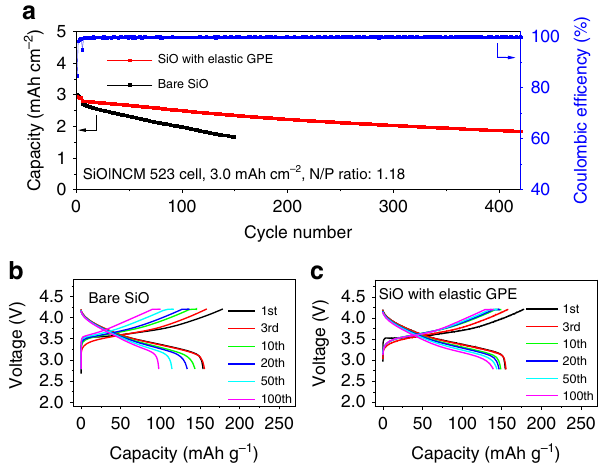
Fig. 5 Cycling stability of SiO|NCM cells. a Discharge capacities of SiO| NCM 523 cells at a current density of 1.0 mA cm − 2 and the Coulombic ef fi ciency of the cell incorporating the elastic GPE. b , c Voltage pro fi les of the SiO|NCM 523 cells with ( b ) and without ( c ) the elastic GPE. Pre-cycled SiO electrodes were used for full-cell assembling. The mass loading of SiO anodes is 4.7 mg cm − 2 , and the copolymer amount is 0.4 mg cm − 2